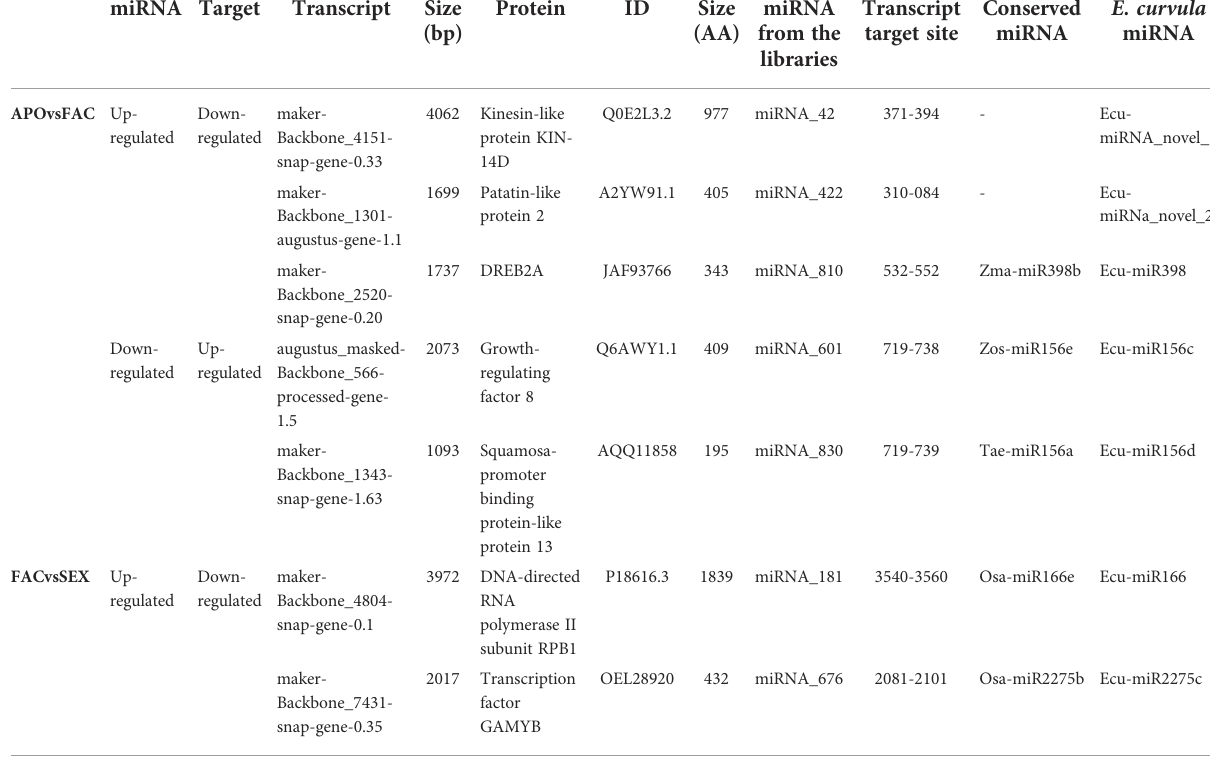
TABLE 4 miRNA-mRNA interactions selected for the